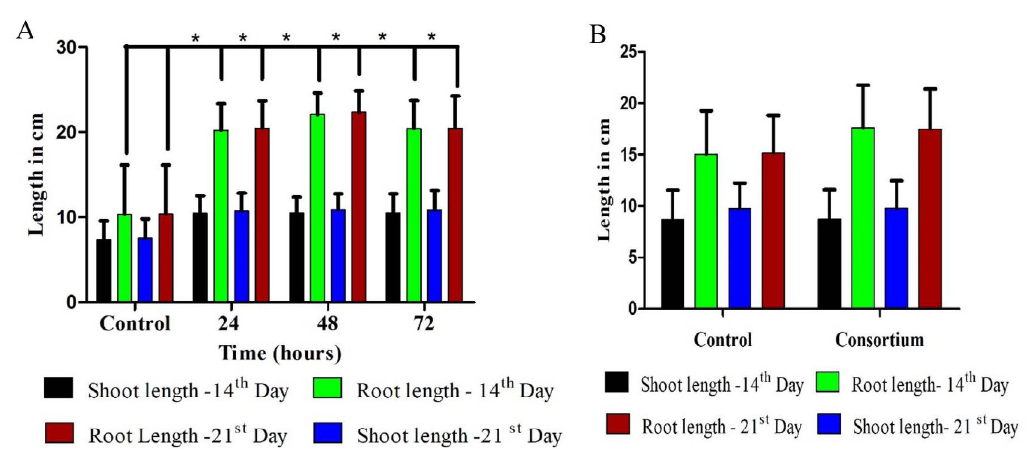
1.1 (A) and consortium (B) on rice plant growth promotion under in 1